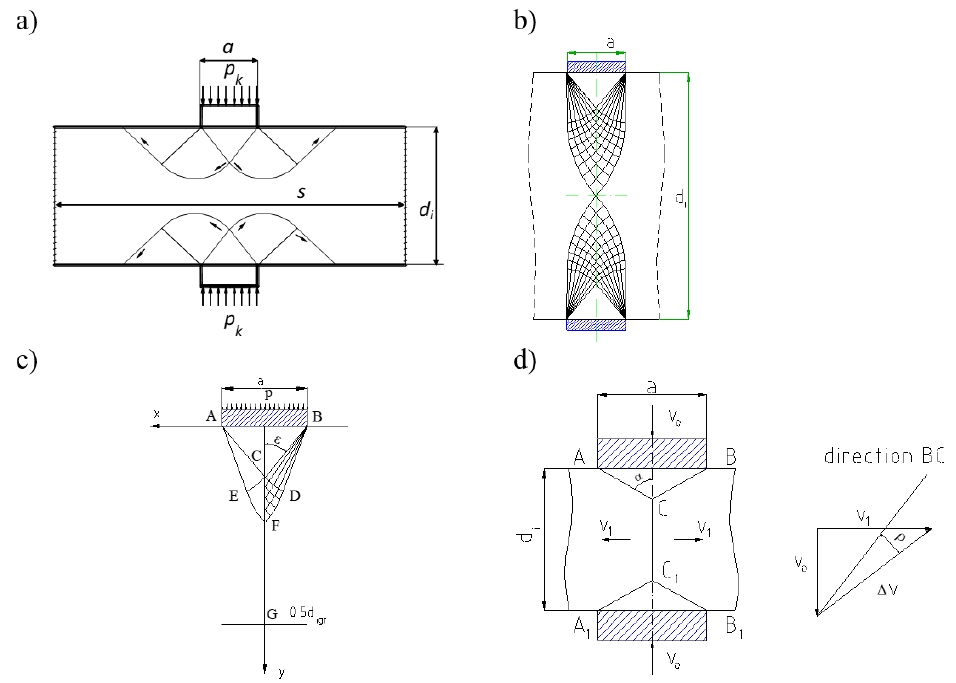
Figure 4: Local and global failure mechanism: a) Prandtl failure mechanism (Prandtl [33] ), b) global failure mechanism (method of characteristics) for di/a = 12.22 and r = 15°, c) solution for the modified Coulomb condition, the method of characteristics grid for r = 10°, S /S = 5, d) determination of the upper limit: block compressed by flat stamps (modified condition) c r